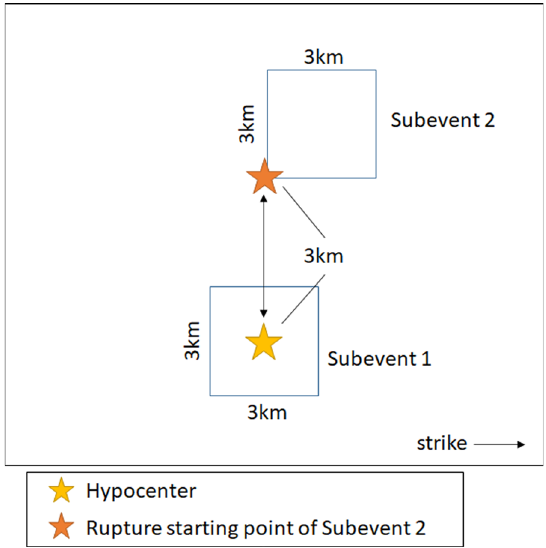
Fig. 7 Subevents of the reference case for the earthquake of 2016/04/14 21:26 ( M w 6.1). Blue rectangles indicate the subevents used for the simulation. The black rectangle represents the fault plane, which is shown only for reference and not considered in the simulation. The yellow star indicates the hypocenter of the target earthquake and the rupture starting point of subevent 1. The orange star indicates the rupture starting point of subevent